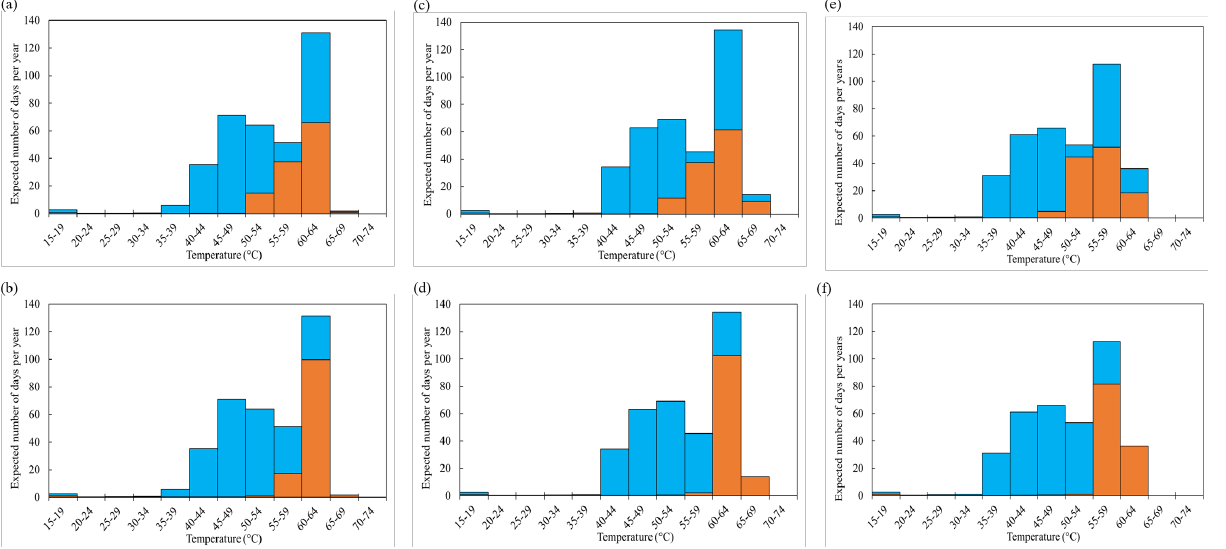
Figure 14. Correlation of influence factors at LT location: ( a ) min saturation under B1, ( b ) max parameter setting under B1, ( c ) min saturation under FSL, ( d ) max parameter setting under FSL, ( e ) min saturation under LSS, ( f ) max parameter setting under LSS.